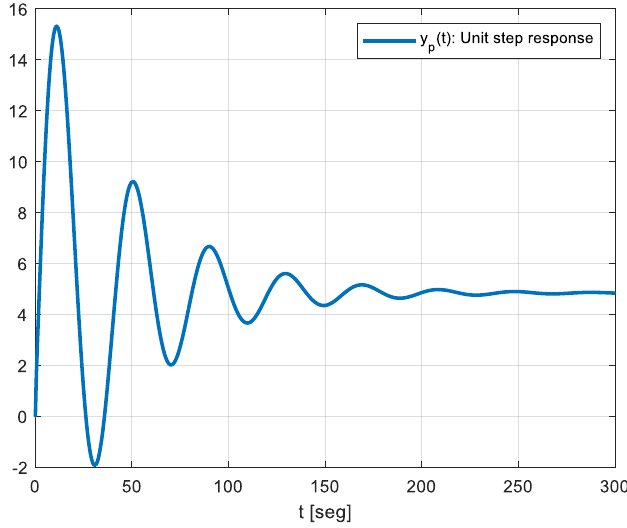
Figure 8. Open − loop system response to a unit step reference change at t = Figure 8. Open−loop system response to a unit step reference change at t = 0.